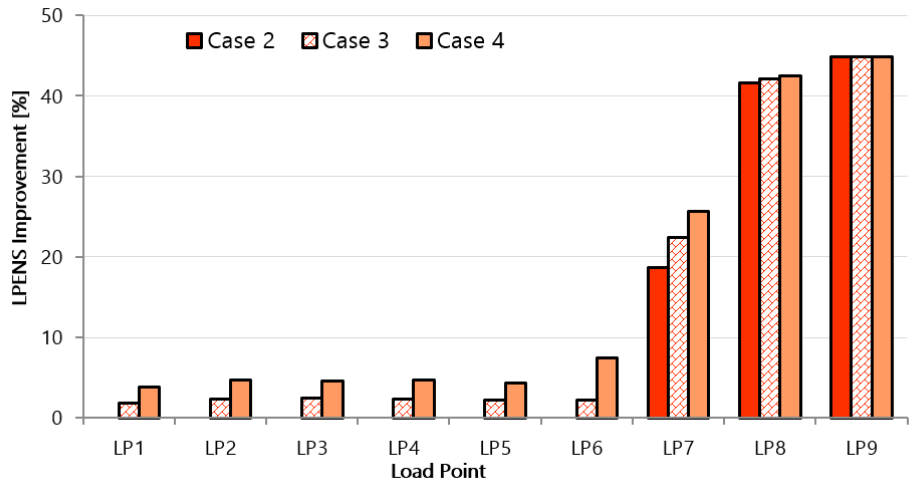
Figure 6. LPENS improvement in load points for case studies compared to